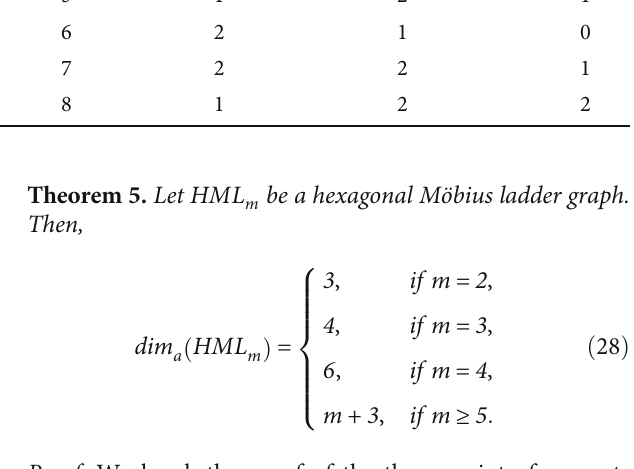
Table 1: Representations of vertices with respect to Q